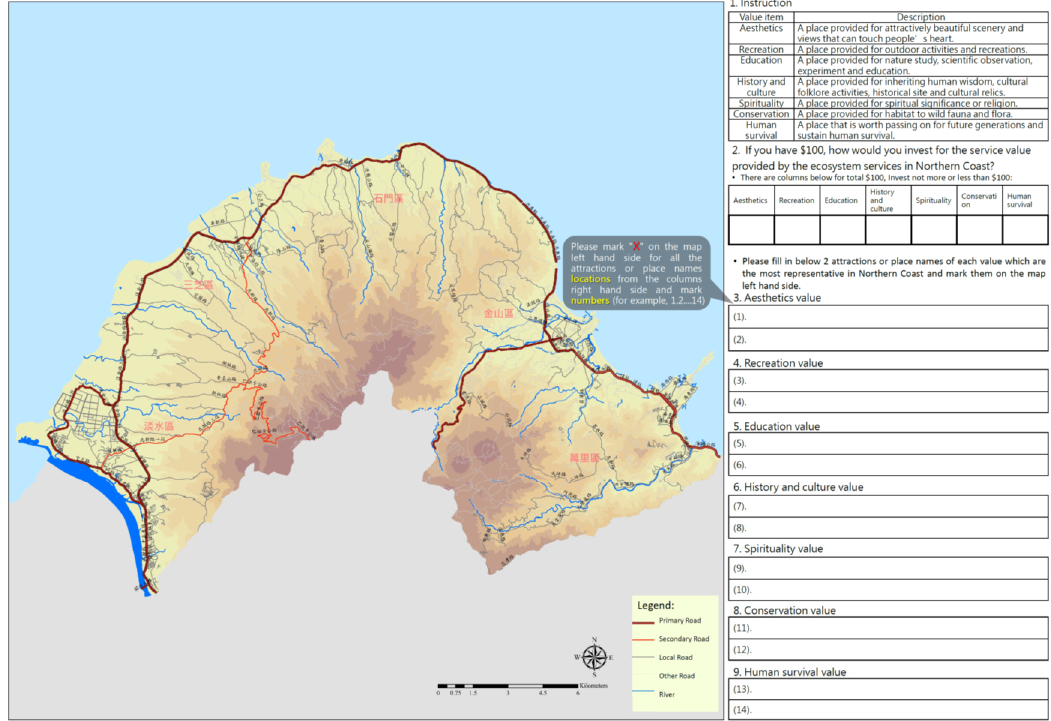
Figure A1. The questionnaire of Social Value.